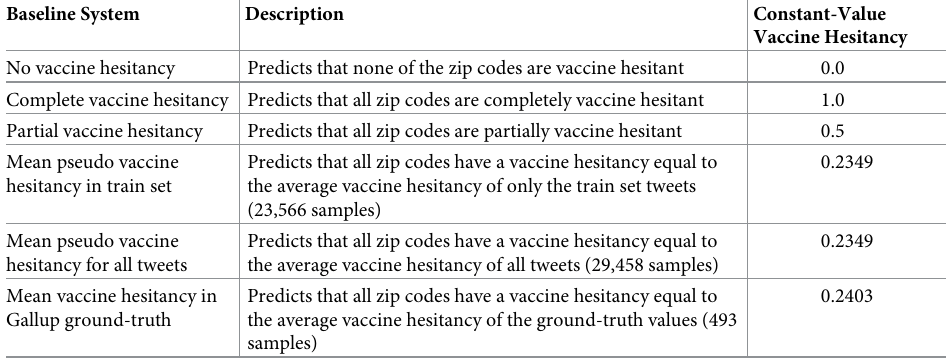
Table 3. Description of the six constant-value baseline models, along with the corresponding vaccine hesitancy value predicted for all tweets and zip codes, for that